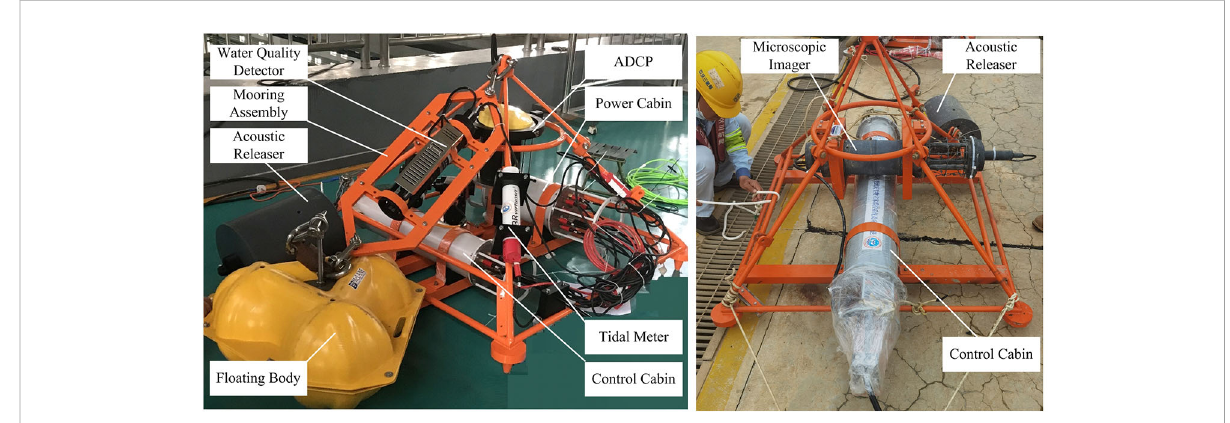
FIGURE 8 Observation node before